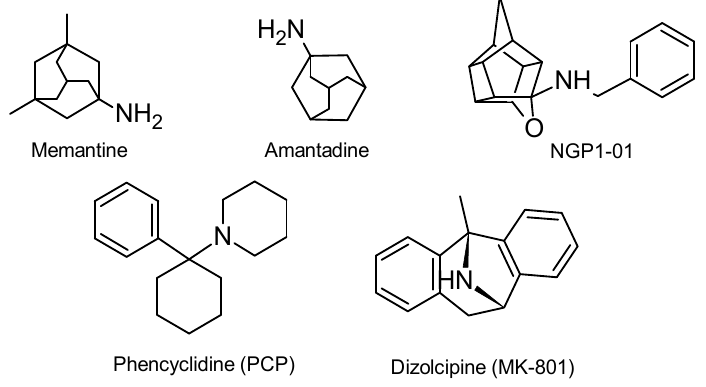
Figure 1. Uncompetitive NMDA receptor antagonists.